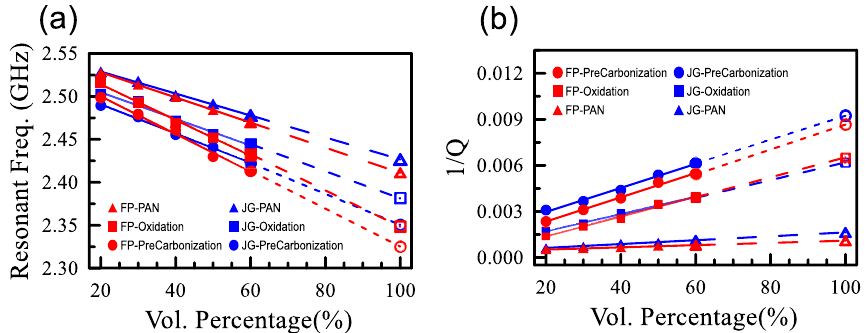
Figure 2. ( a ) Resonant frequencies and ( b ) reciprocals of Q -factors as functions of the volumetric percentages. The fibers at three stages from two companies are measured. The resonant frequencies are inversely proportional to the volumetric percentages, while the reciprocals of Q -factors are proportional to the volumetric percentages.